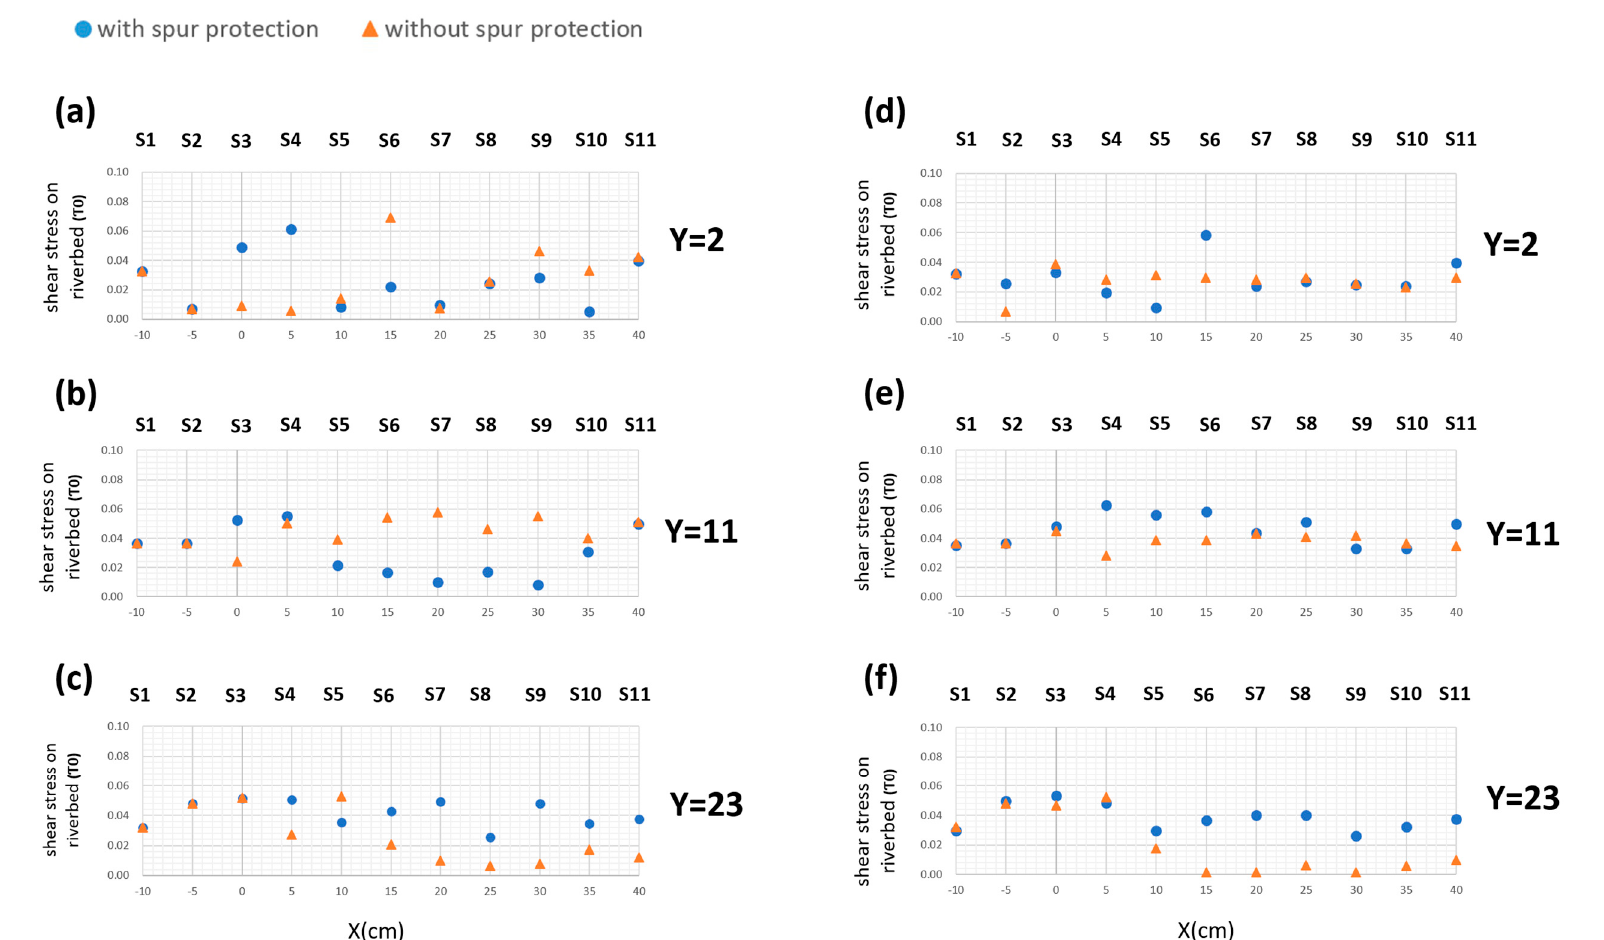
Figure 10. The distribution of shear stress of the river bed with flood recurrence interval is ( a )–( c ) 10 years, and ( d )–( f ) 20 years.